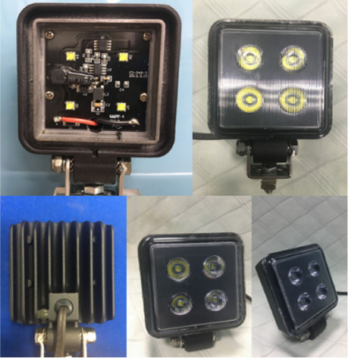
Figure 1. Light-emitting diode (LED)